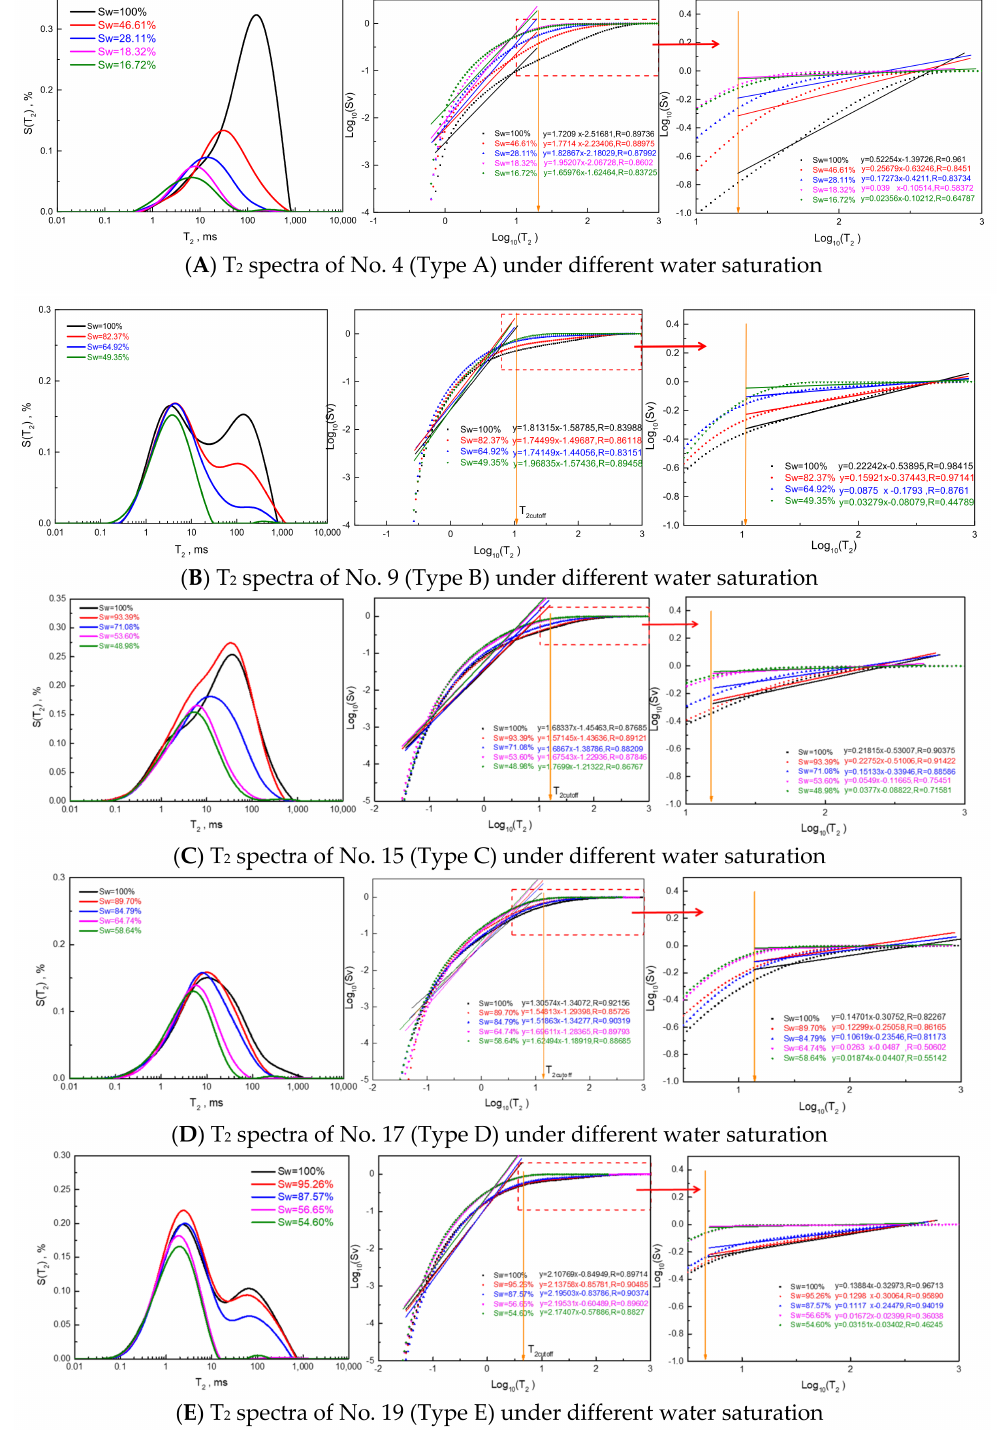
Figure 5. T 2 spectra under different water saturation states of a representative rock sample of each pore structure